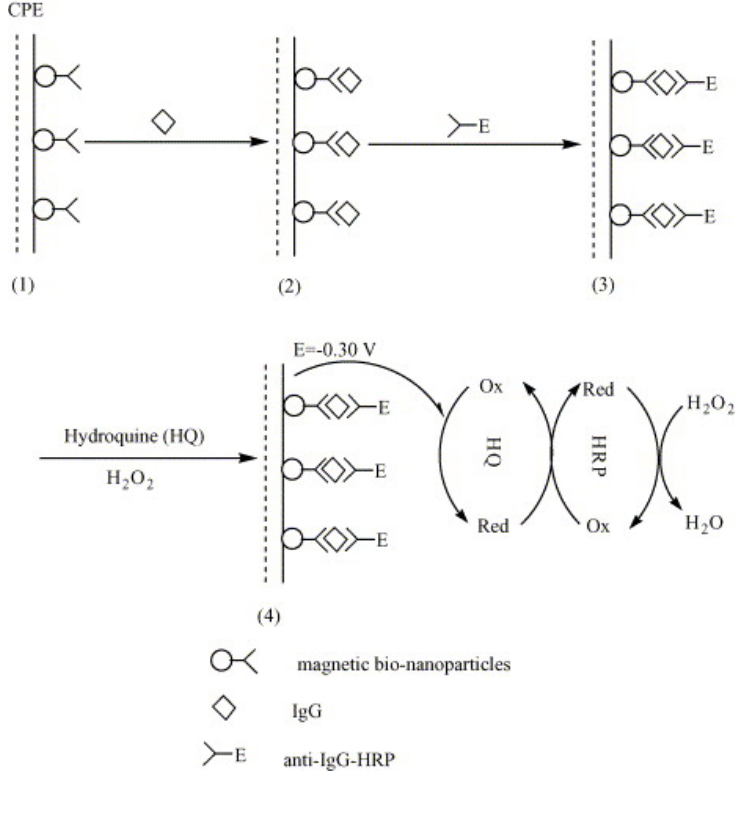
Figure 3. Preparation of the immunosensor and its application in IgG determination: (1) magnetic bio-nanoparticles containing anti-IgG were attached on the surface of carbon paste electrode in the presence of magnetic field; (2) incubation of the immunosensor with IgG solutions allowed formation of the anti-IgG/IgG complex on the electrode; (3) incubation of the immunosensor in HRP-labeled anti-IgG solutions allowed formation of anti-IgG/IgG/anti-IgG-HRP complex on the electrode; (4) hydroquinone and H added and electrode-bound IgG was determined by amperometric measurements at an potential of - 300mV (vs. SCE) (reproduced with permission from reference